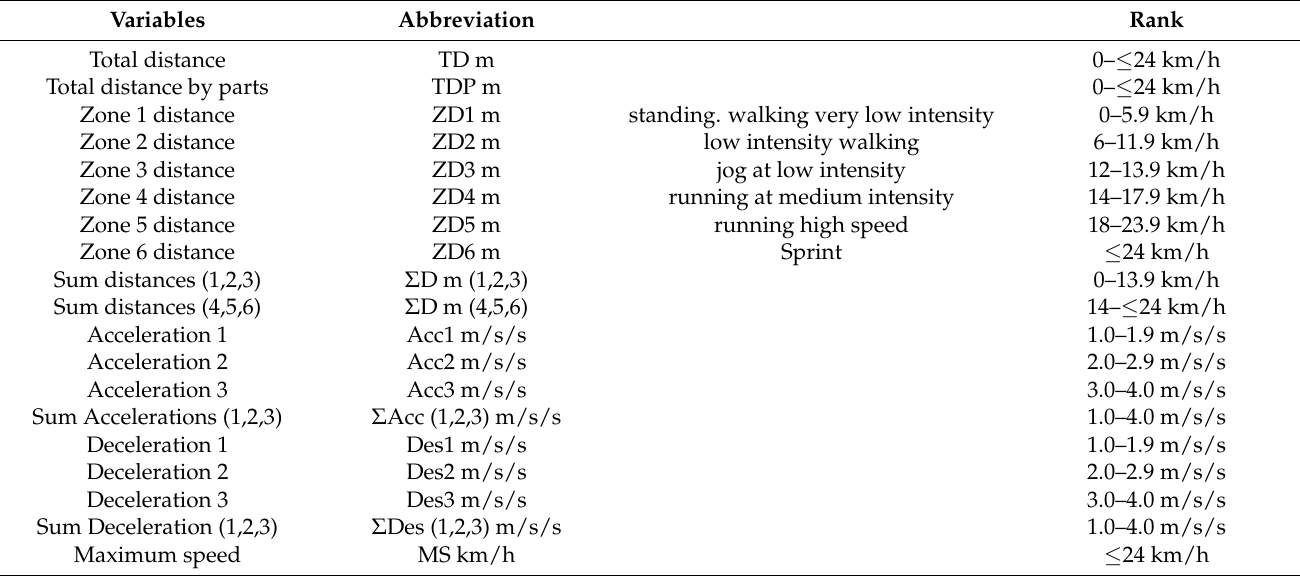
Table 1. Speed thresholds for the reported match